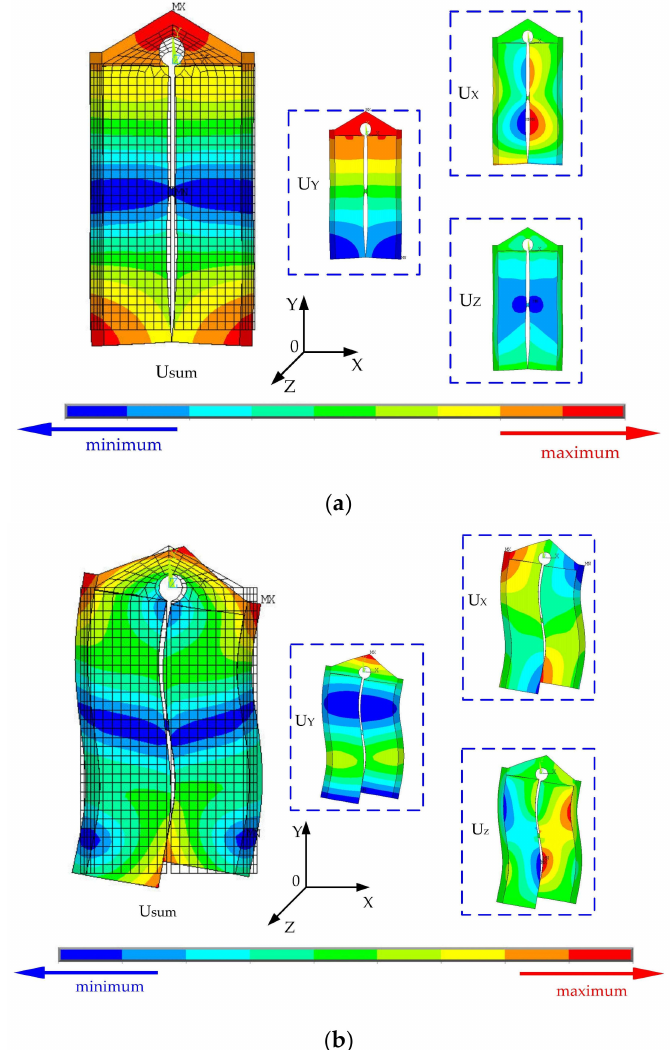
Figure 9. Results of modal analysis: ( a ) Symmetric mode; ( b ) anti-symmetric